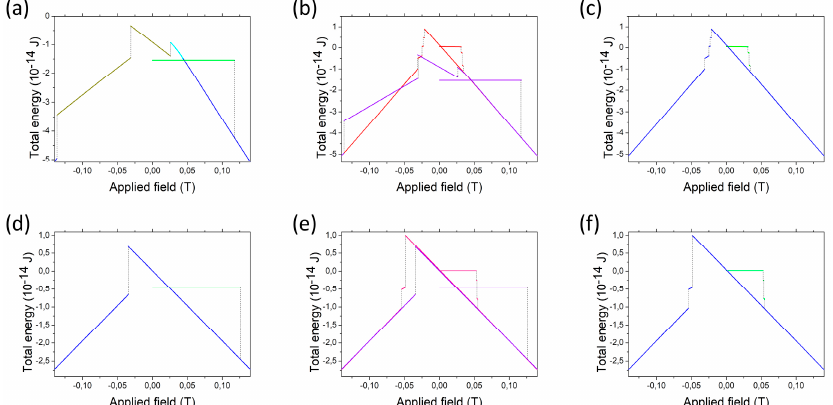
Figure 12. Energies of the subsequent configurations of the models of 8 stripes and ellipsoids discussed in this section, upper panel: stripes, lower panel: ellipsoids. The leftmost ( a , d ) S-W model, the rightmost ( c , f ) micromagnetic calculations, the central parts ( b , e ) comparison of both.